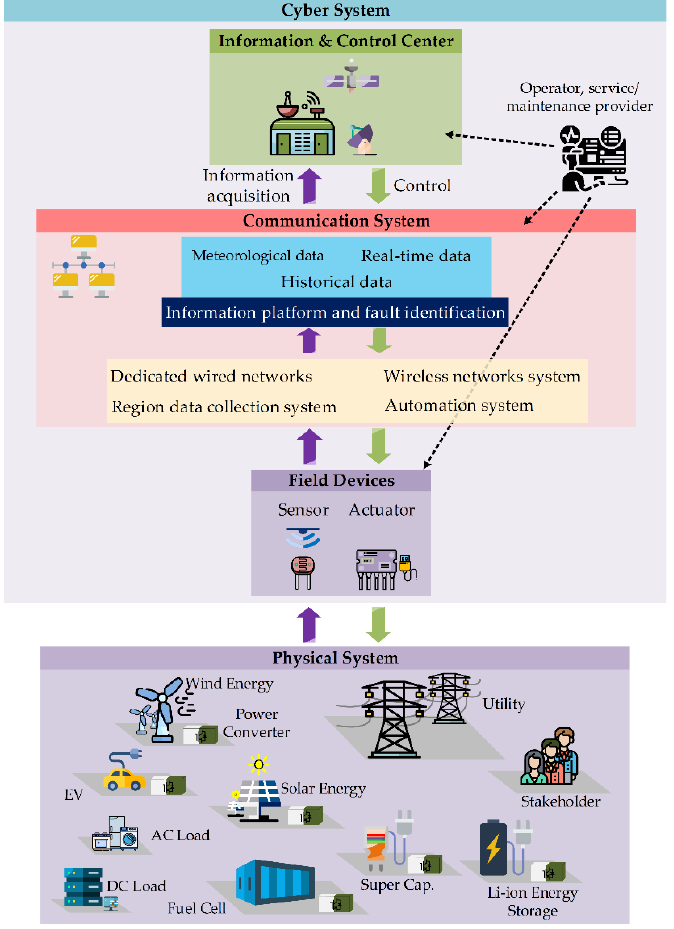
Figure 1. A typical smart microgrid with cyber-physical systems.